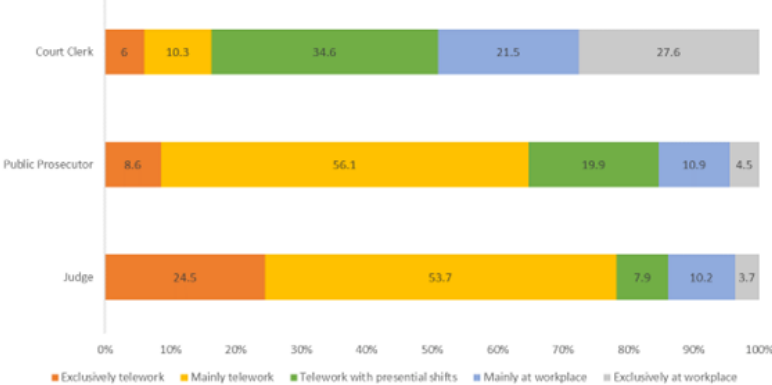
Figure 3: Work Regime During Confinement by Judicial Profession